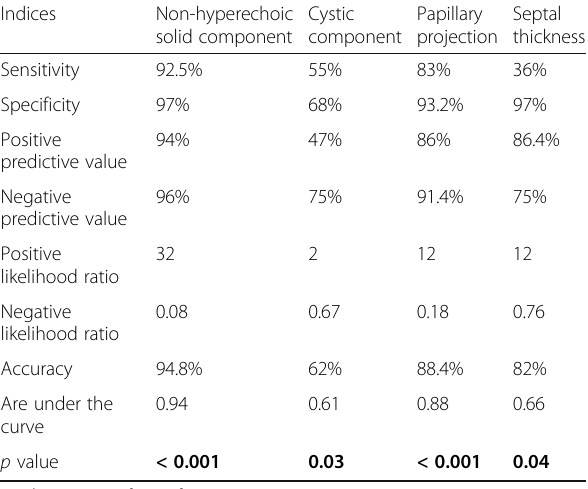
Table 1 Diagnostic performance of the gray-scale US features